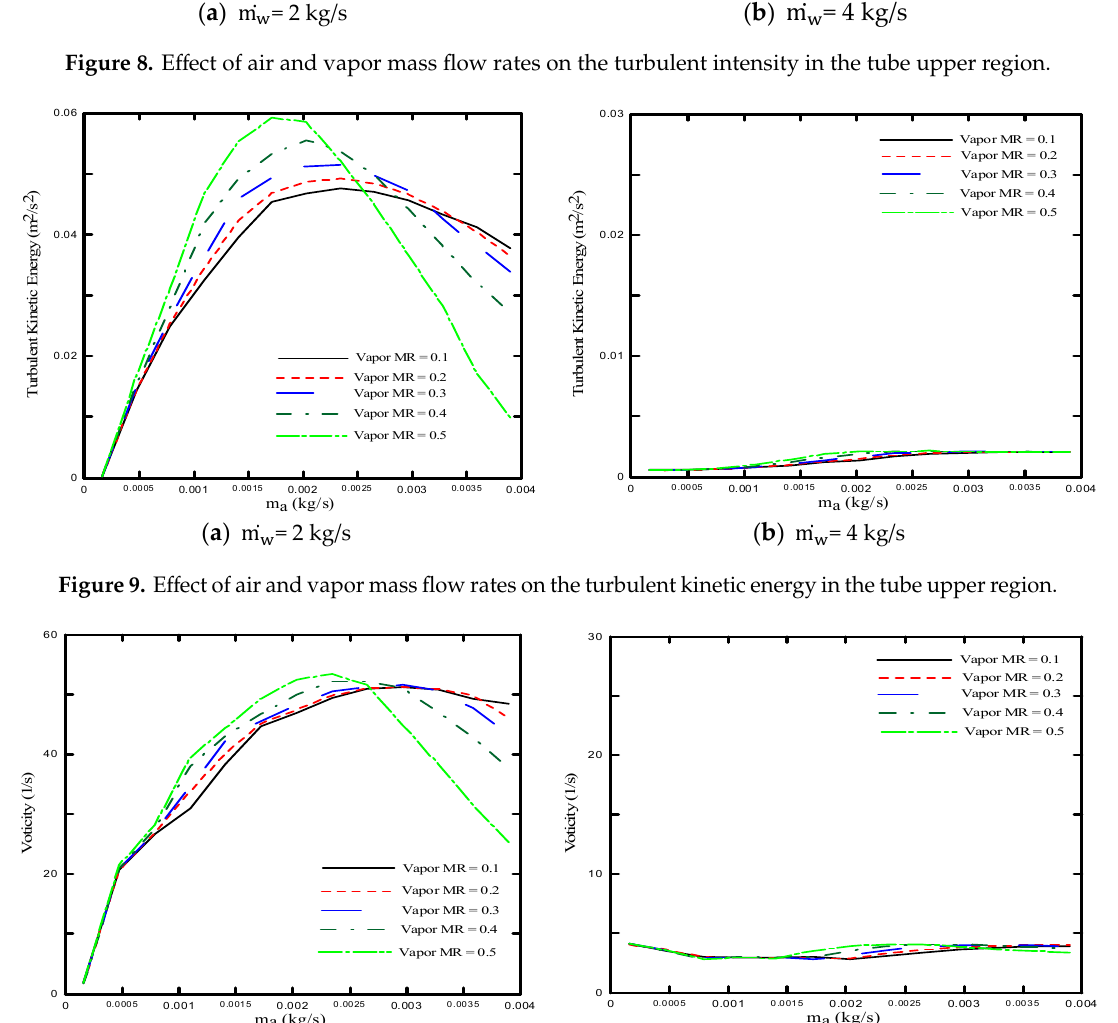
Figure 10. Effect of air and vapor mass flow rates on the flow velocity in the tube upper region. The effect of flow mass ratios of water, water vapor, and air on the static pressure contours are